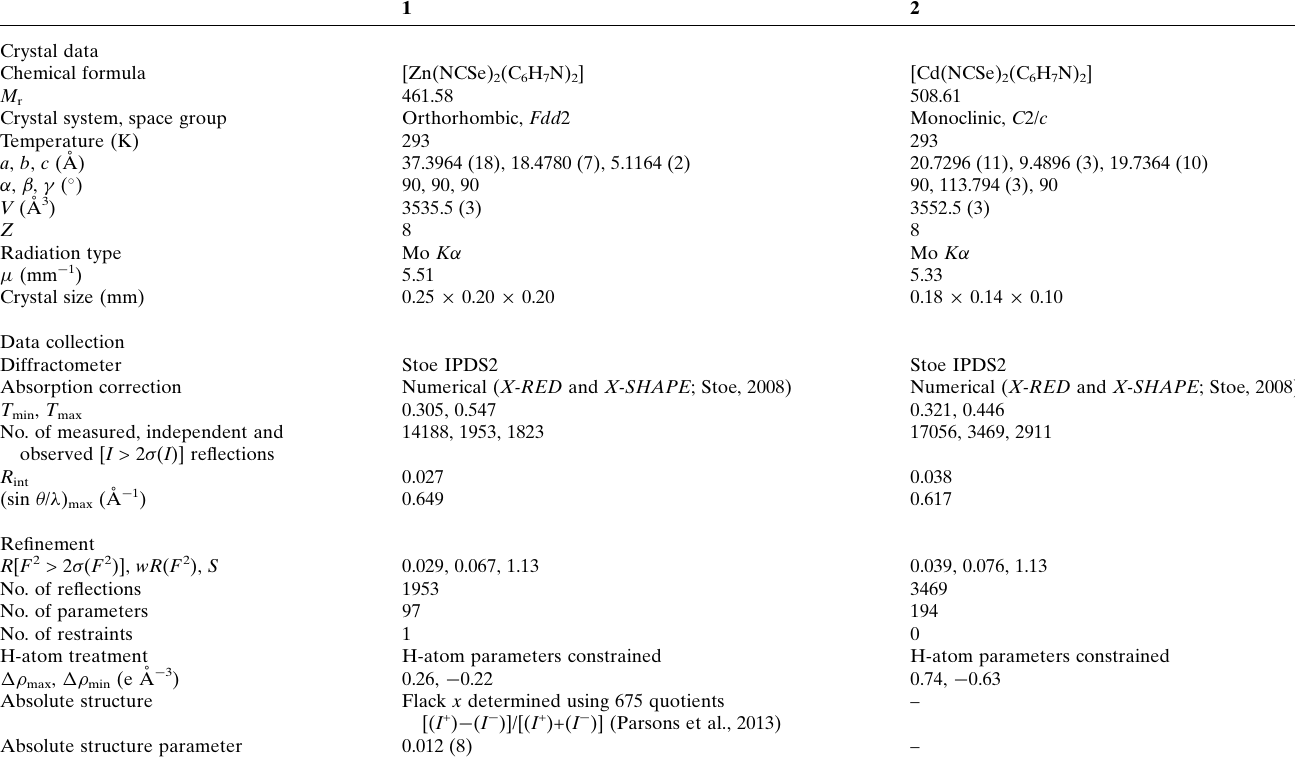
Table 3 Experimental